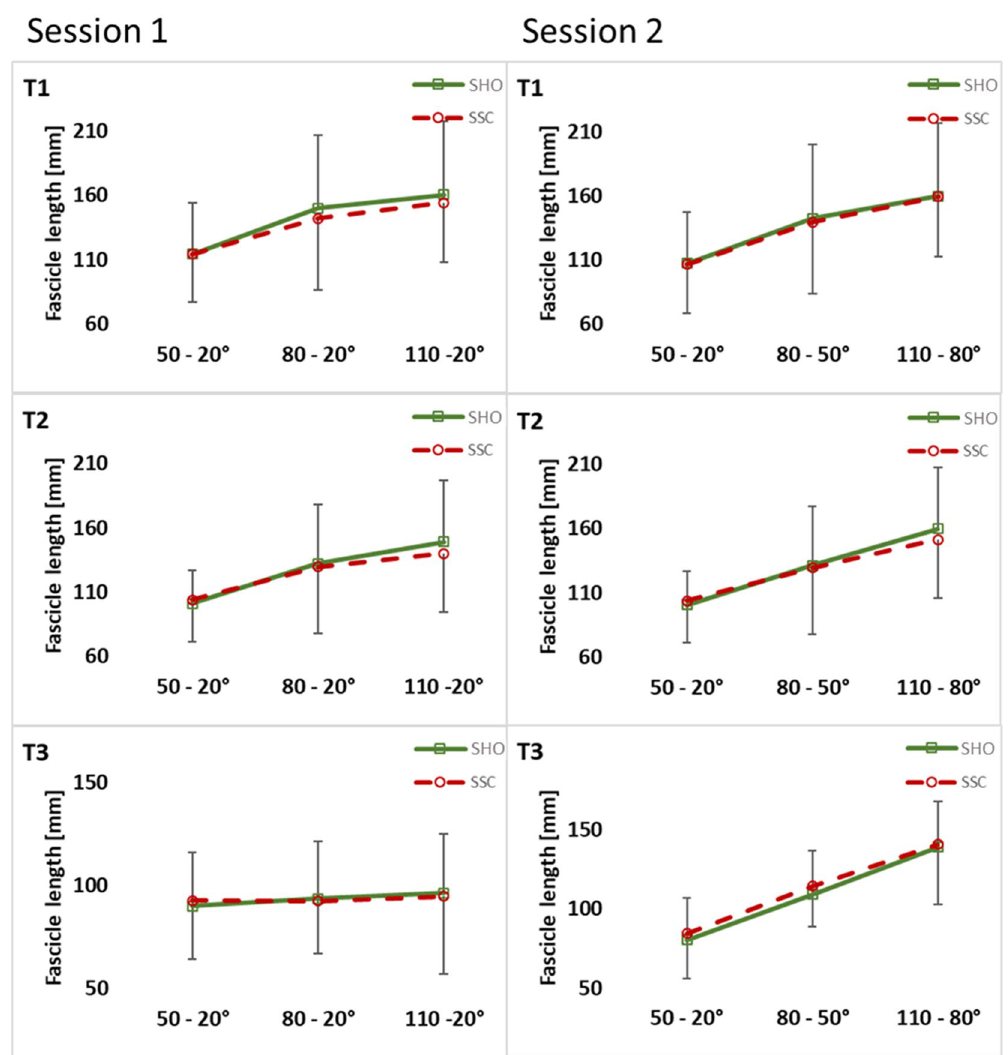
Figure 8. Mean (± SD, n = 25) values of fascicle length in both test sessions. T1 is the time point at the onset of shortening, T2 in the middle of the shortening phase, T3 the time point at steady-state after the dynamic